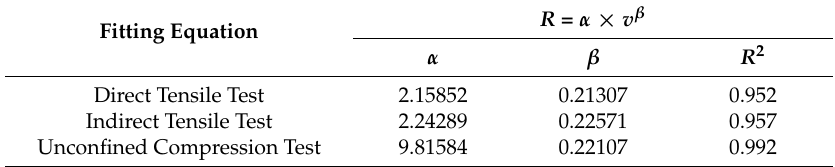
Table 10. Fitting curve equations of the relation between strength and loading rate under various loading